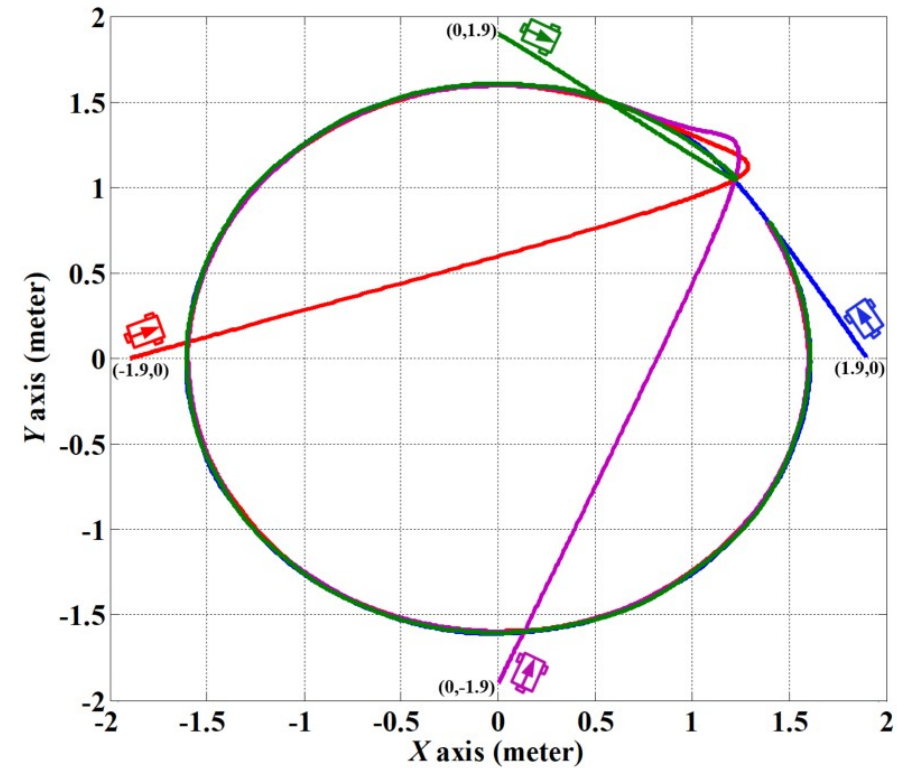
Figure 2. Circular trajectory tracking result of H 2 proposed control design with respect to four different initial conditions: ( x c = 1.9 m, y c = 0 m, blue line), ( x c = − 1.9 m, y c = 0 m, red line), ( x c = 0 m, y c = 1.9 m, green line), and ( x c = 0 m, y c = − 1.9 m, purple line).